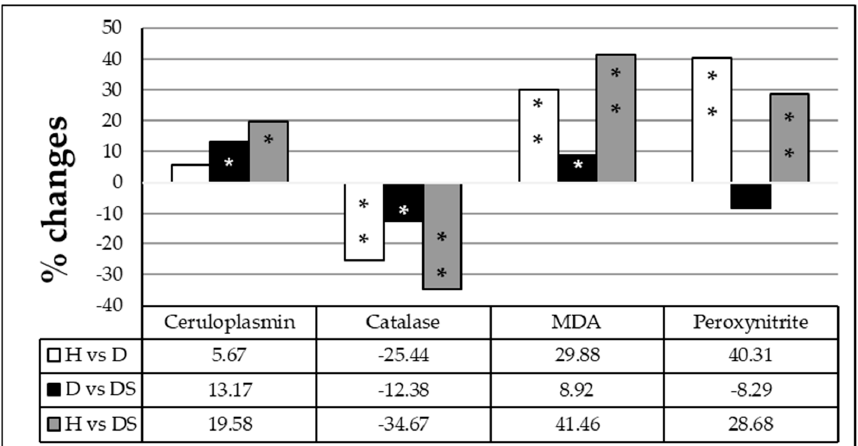
Figure 4. Percentage of change in the oxidative stress parameters ceruloplasmin, catalase, and malondialdehyde (MDA) among healthy individuals (H), diabetic patients (D), and diabetic patients sweetener consumers (DS). The comparison was performed using one-way ANOVA. Values presenting p > 0.05 were considered non-significant (NS). Significant values are represented by * p < 0.05 and ** p < 0.001.